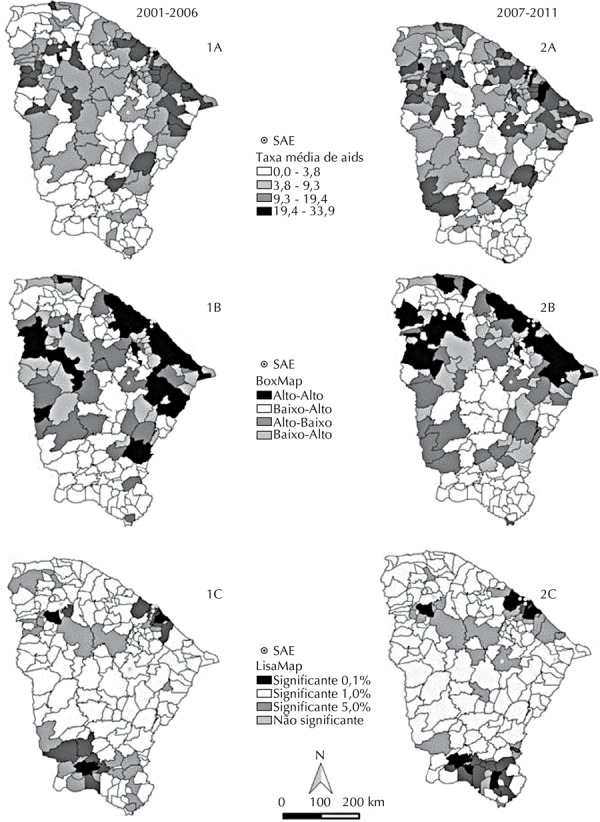
Distribuição geográfica dos Serviços de Assistência Especializada (SAE), taxas médias (mapas 1A e 2A), BoxMap (mapas 1B e 2B) e LisaMap (mapas 1C e 2C) das taxas de aids segundo Diagrama de Espalhamento de Moran, no estado do Ceará, Brasil, 2001-2011.